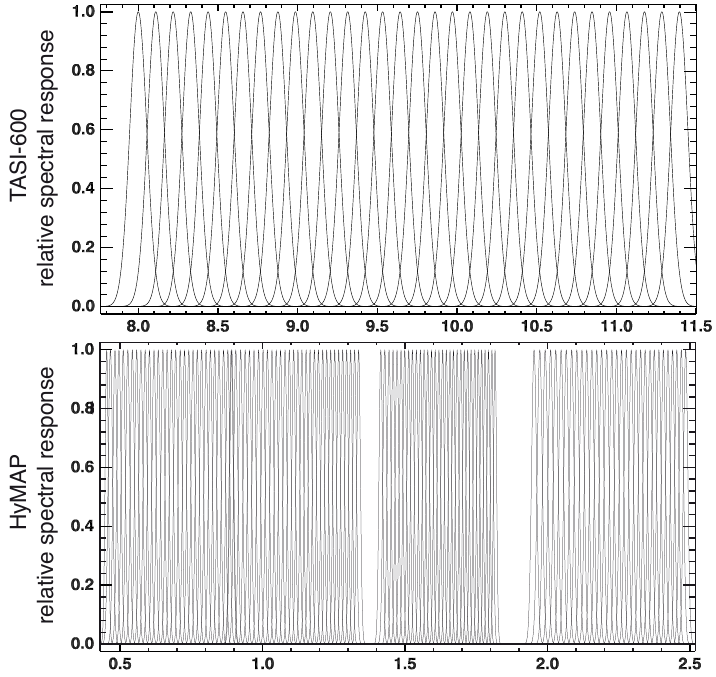
Figure 1. Spectral Response Functions (SRF) used to simulate the TASI-600 and HyMAP sensors’ spectral